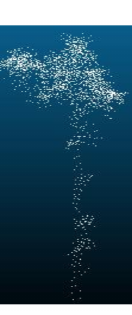
Figure 12. Misclassification of tree species: ( a ) Larch was mistaken for white birch; ( b ) White birch was mistaken for larch.